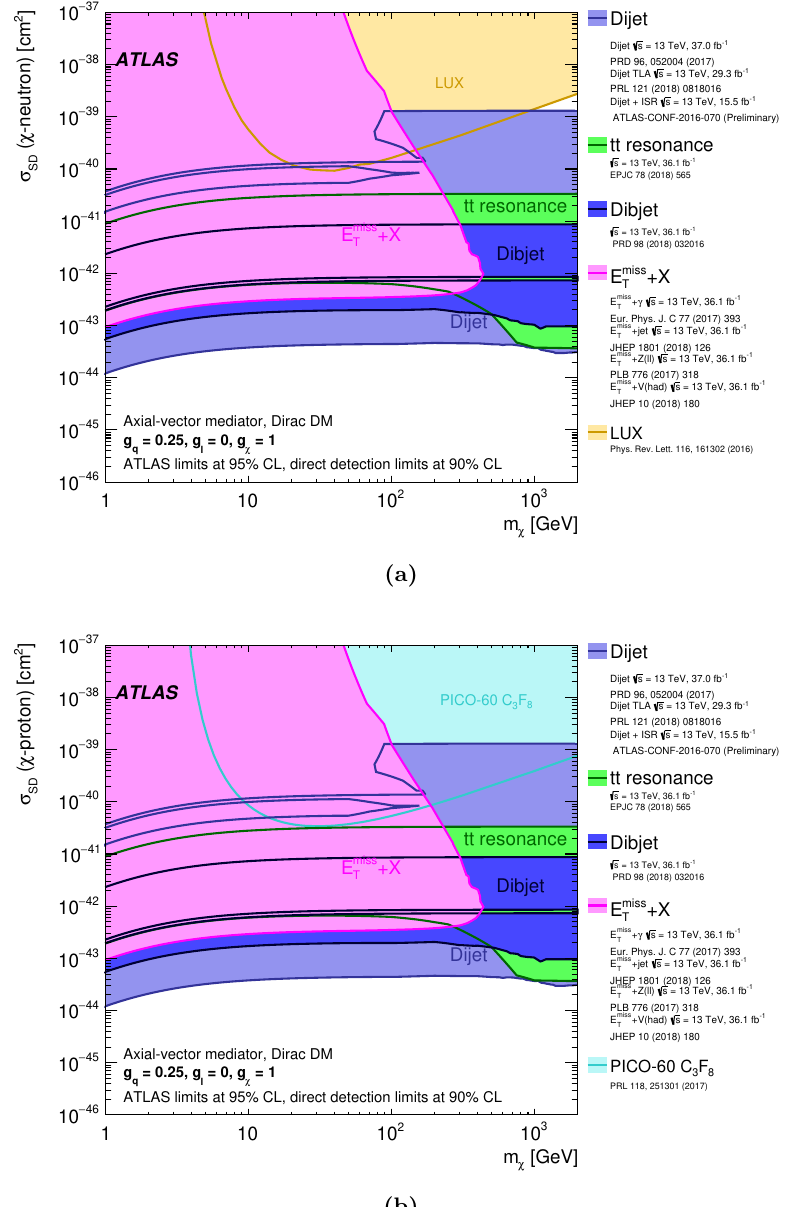
Figure 24. A comparison of the inferred limits with the constraints from direct detection ex- periments on (a) the spin-dependent WIMP-neutron or (b) WIMP-proton scattering cross-section in the context of the Z 0 -like simpli(cid:12)ed model with axial-vector couplings. The results from this analysis, excluding the region to the left of the contour, are compared with limits from direct de- tection experiments. LHC limits are shown at 95% CL and direct detection limits at 90% CL. The comparison is valid solely in the context of this model, assuming a mediator width (cid:12)xed by the dark matter mass and coupling values g q = 0 : 1 ; g ‘ = 0 : 1, and g (cid:31) = 1. LHC searches and direct detection experiments exclude the shaded areas. Exclusions of smaller scattering cross-sections do not imply that larger scattering cross-sections are also excluded. The resonance and E miss +X exclusion region T represents the union of exclusions from all analyses of that